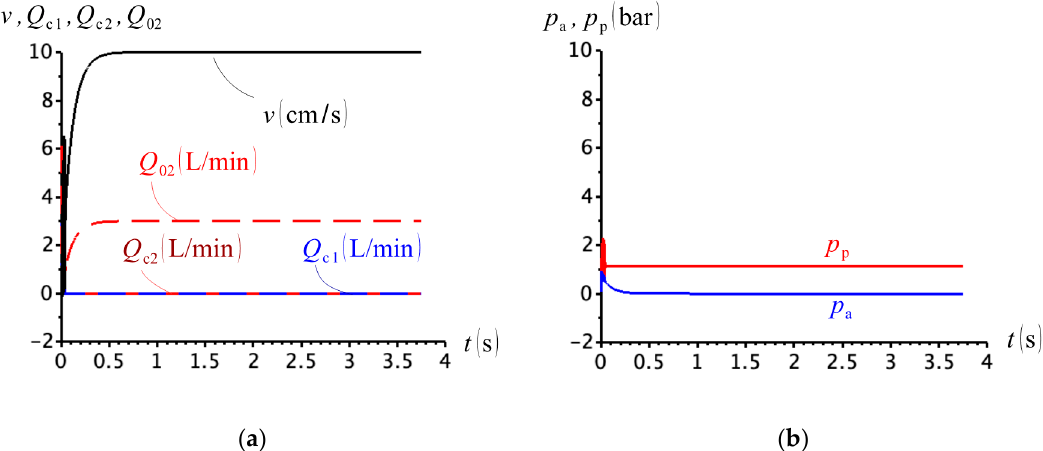
Figure 18. ( a ) Cylinder velocity and compensation flows; ( b ) cap- and rod-side pressures ( m = 0.5 kg ) .